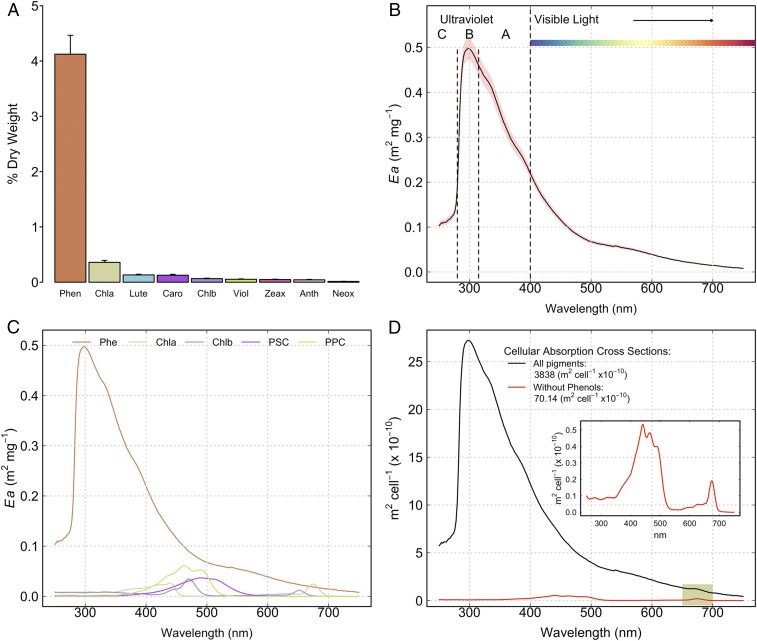
Glacier algal pigmentation and biooptical properties. (A) Cellular contents of all glacier algal pigments, including phenolics (Phen), chlorophyll a (Chla), lutein (Lut), β-carotene (Caro), chlorophyll b (Chlb), violaxanthin (Viol), zeaxanthin (Zea), antheraxanthin (Anth), and neoxanthin (Neox). (B) Mass absorption coefficients of glacier algal phenolic extracts across the UV and visible spectrum. (C) Comparison of the mass absorption coefficients of all major pigment types (phenolics [Phe] measured here and chlorophyll a [Chla], chlorophyll b [Chlb], photosynthetic carotenoids [PSC], and photoprotective carotenoids [PPC] from ref. 34). (D) Glacier algae single-cell absorption cross-sections, showing absorption cross-sections for the complete complement of glacier algal pigments (black line), absorbance without secondary phenolic pigmentation (red line and Inset), and highlighting the notable absorption feature related to chlorophyll a at λ675nm (green shaded region).